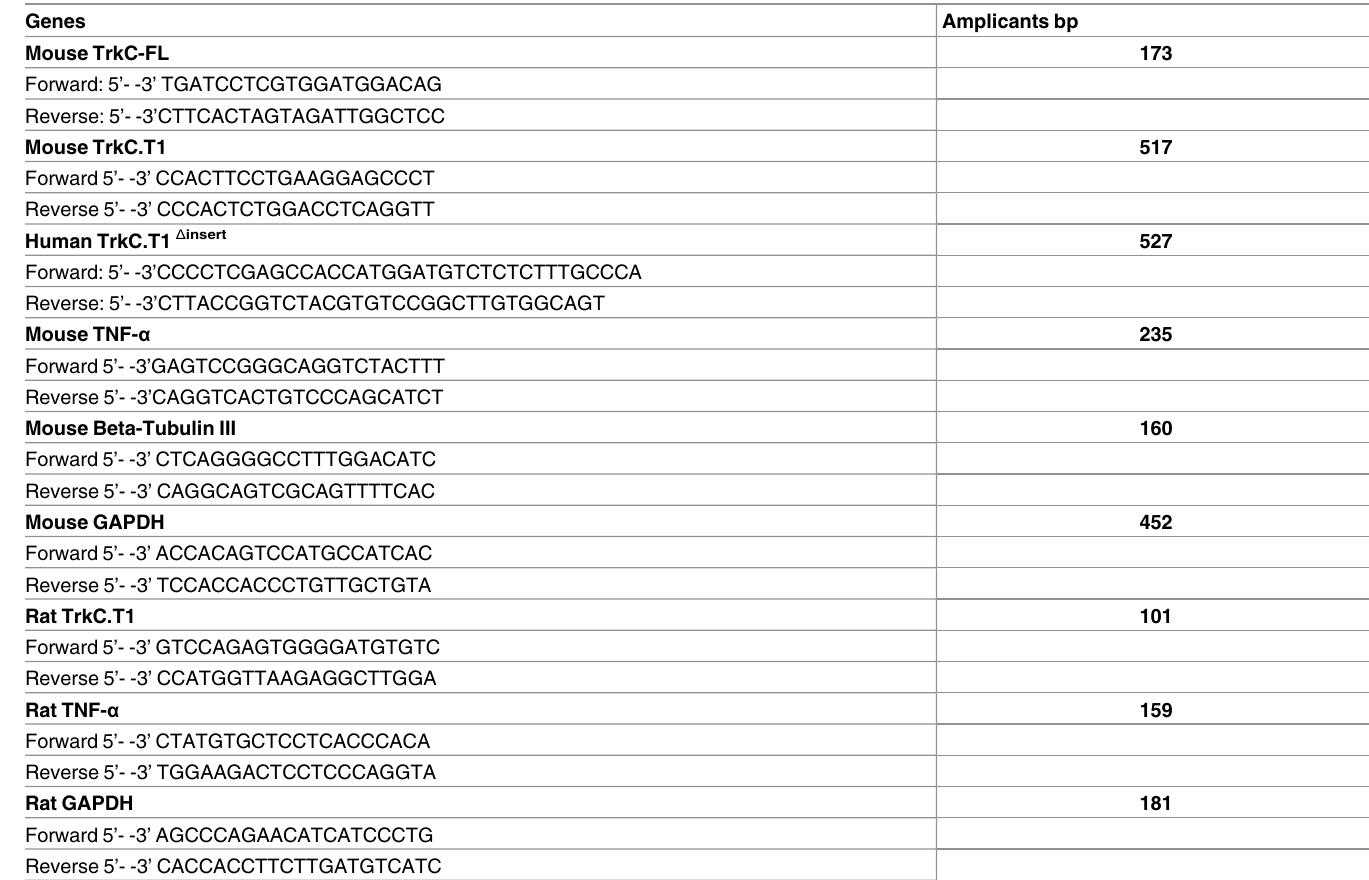
Table 1. Sequences of the